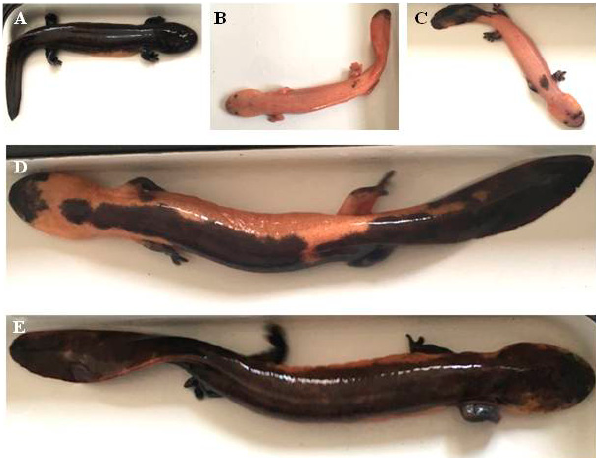
Figure 1. Five different body colors. Full-length range: 12–17 cm; Body weight range: 25–31 g. ( A ) regular gray (wild-type phenotype, GY); ( B ) whole yellow (albino phenotype, YL); ( C ) main yellow but black spot (YB); ( D ) main black but yellow spot, BY: 10% < yellow < 50%; ( E ) main black but yellow spot, BSY: yellow < 10%.